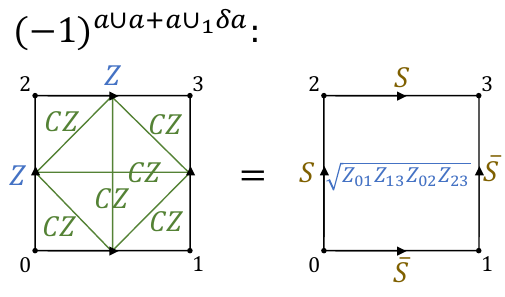
Figure 14: “Electric” string operator.